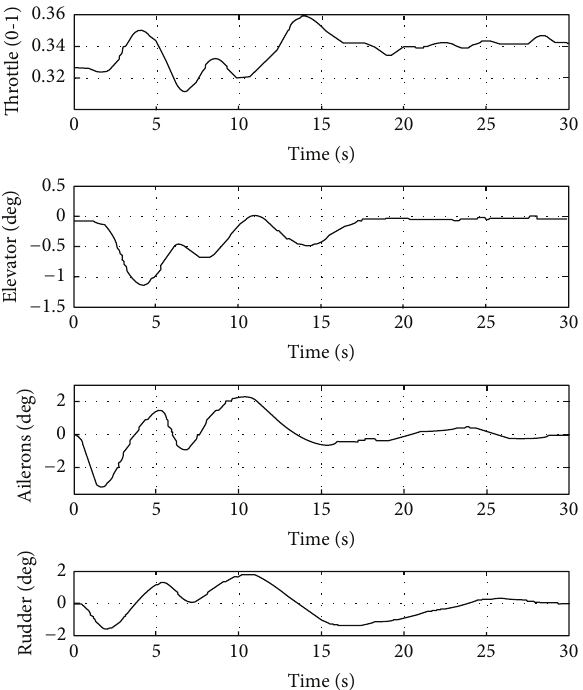
Figure 13: Control variables evolution during the 45-feet heading angle